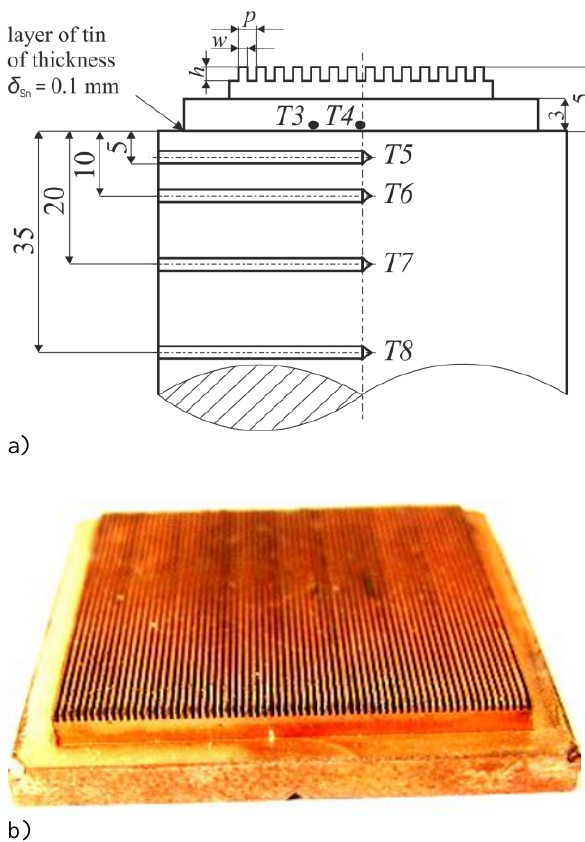
Fig. 1. Main module; 1 – top flange, 2 – boiling liquid, 3 – glass vessel, 4 – specimen, 5 – Teflon annular flange, 6 – copper bar, 7 – insulation, 8 – cartridge heater, 9 – bottom insulation, 10 – retaining flange, 11 – thermocouples, 12 – digital camera, 13 – lights, 14 – condenser, DAS – Data Acquisition System.